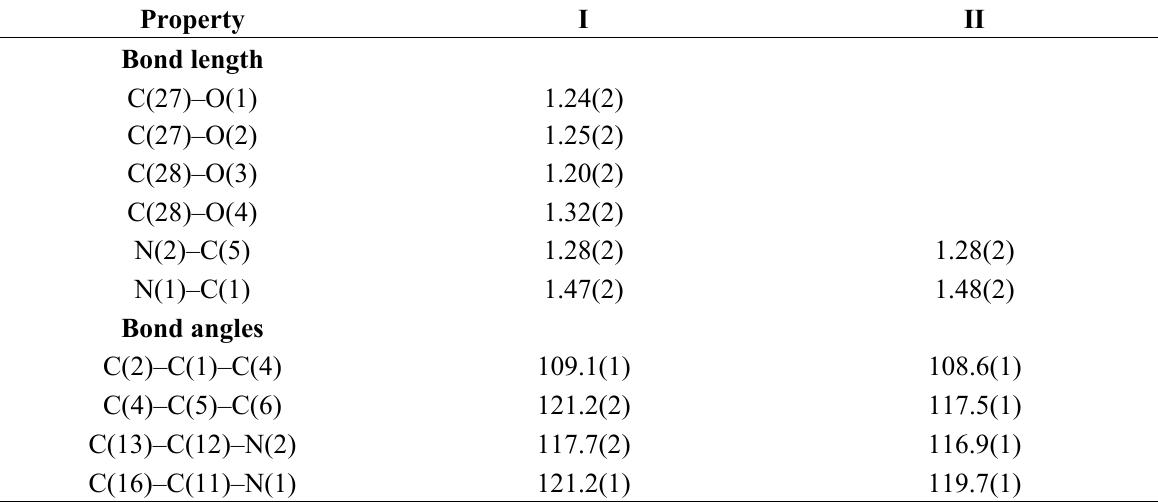
Table 2. Selected bond lengths (Å), angles (°) and torsion angles for compounds I and II